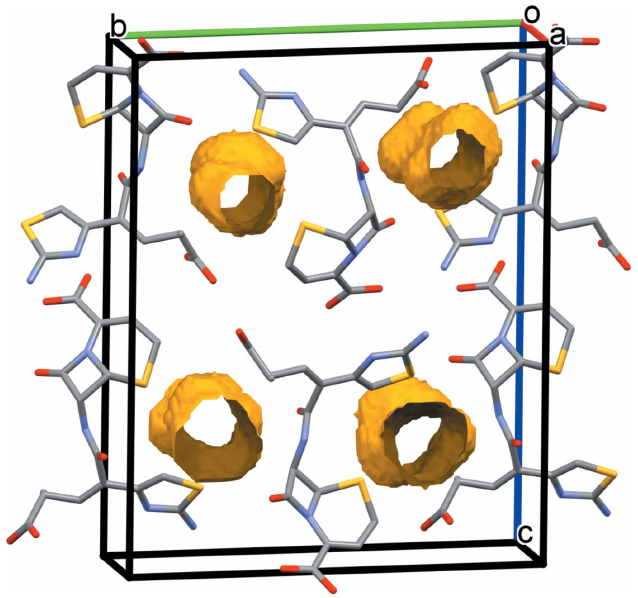
Figure 3 Packing diagram of (I). Void spaces are shown in orange. Hydrogen atoms are omitted for